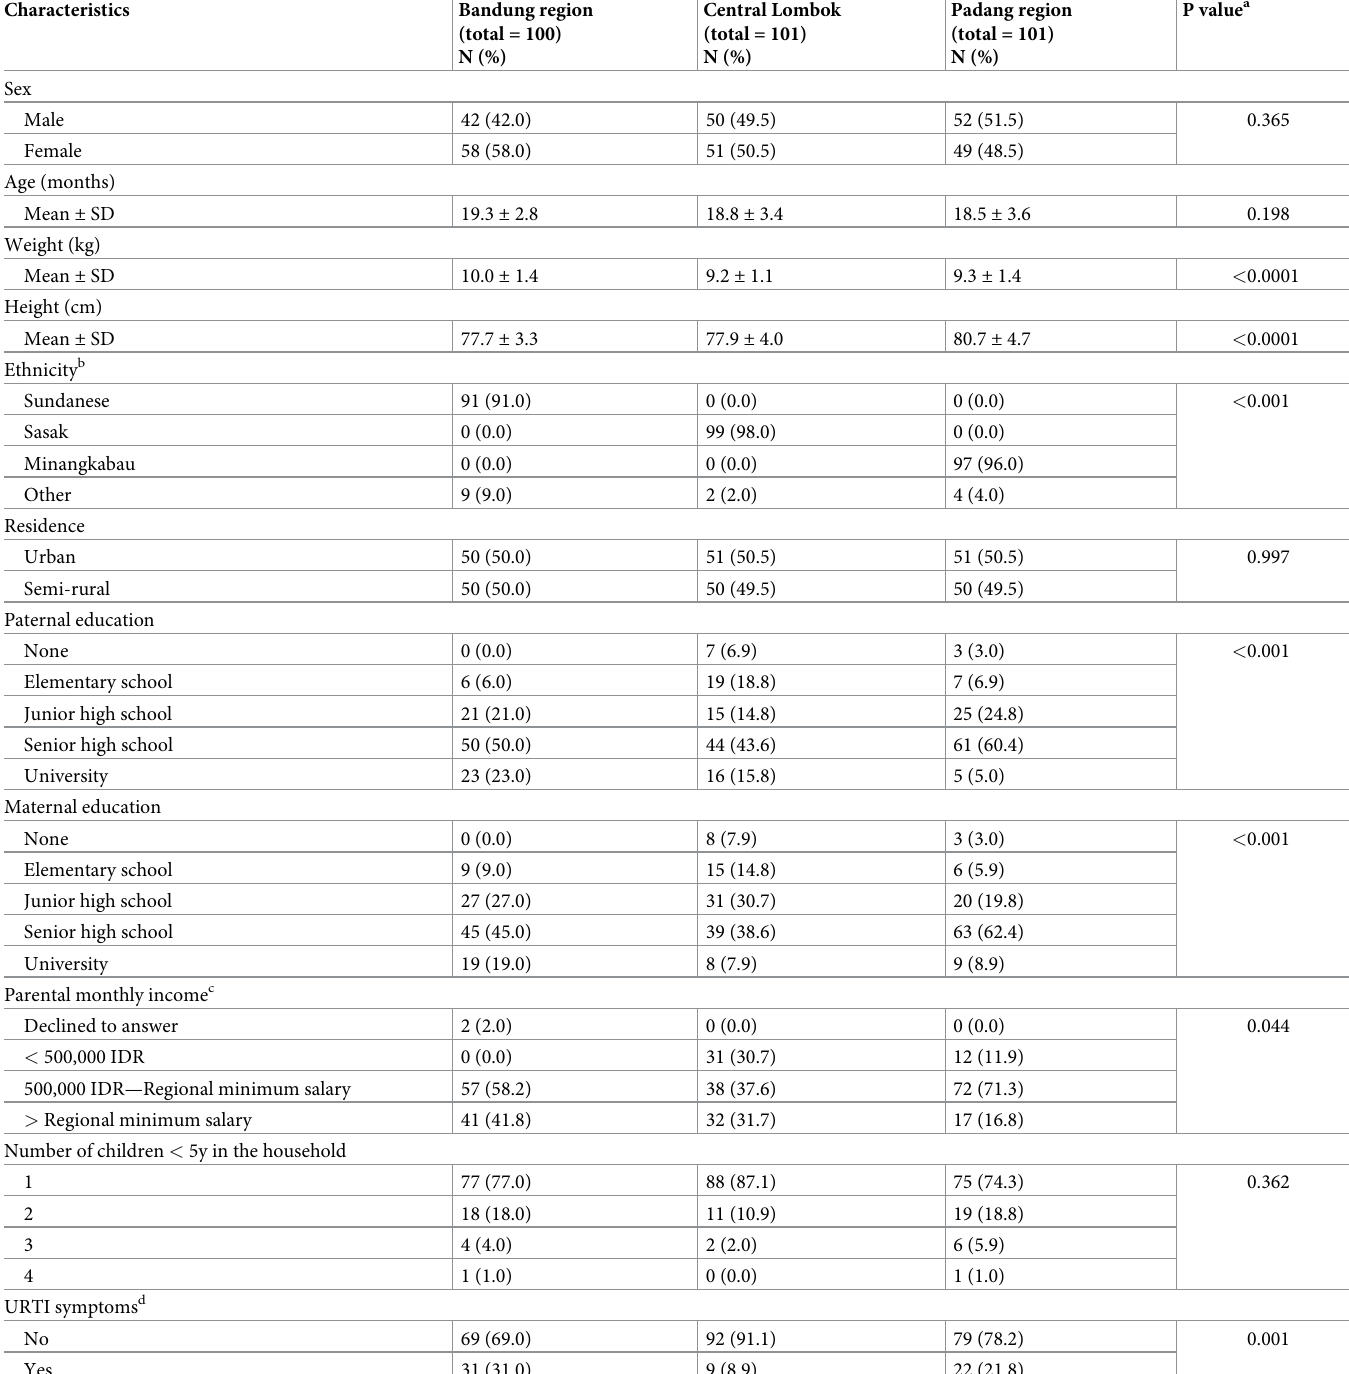
Table 1. Characteristics of study participants.